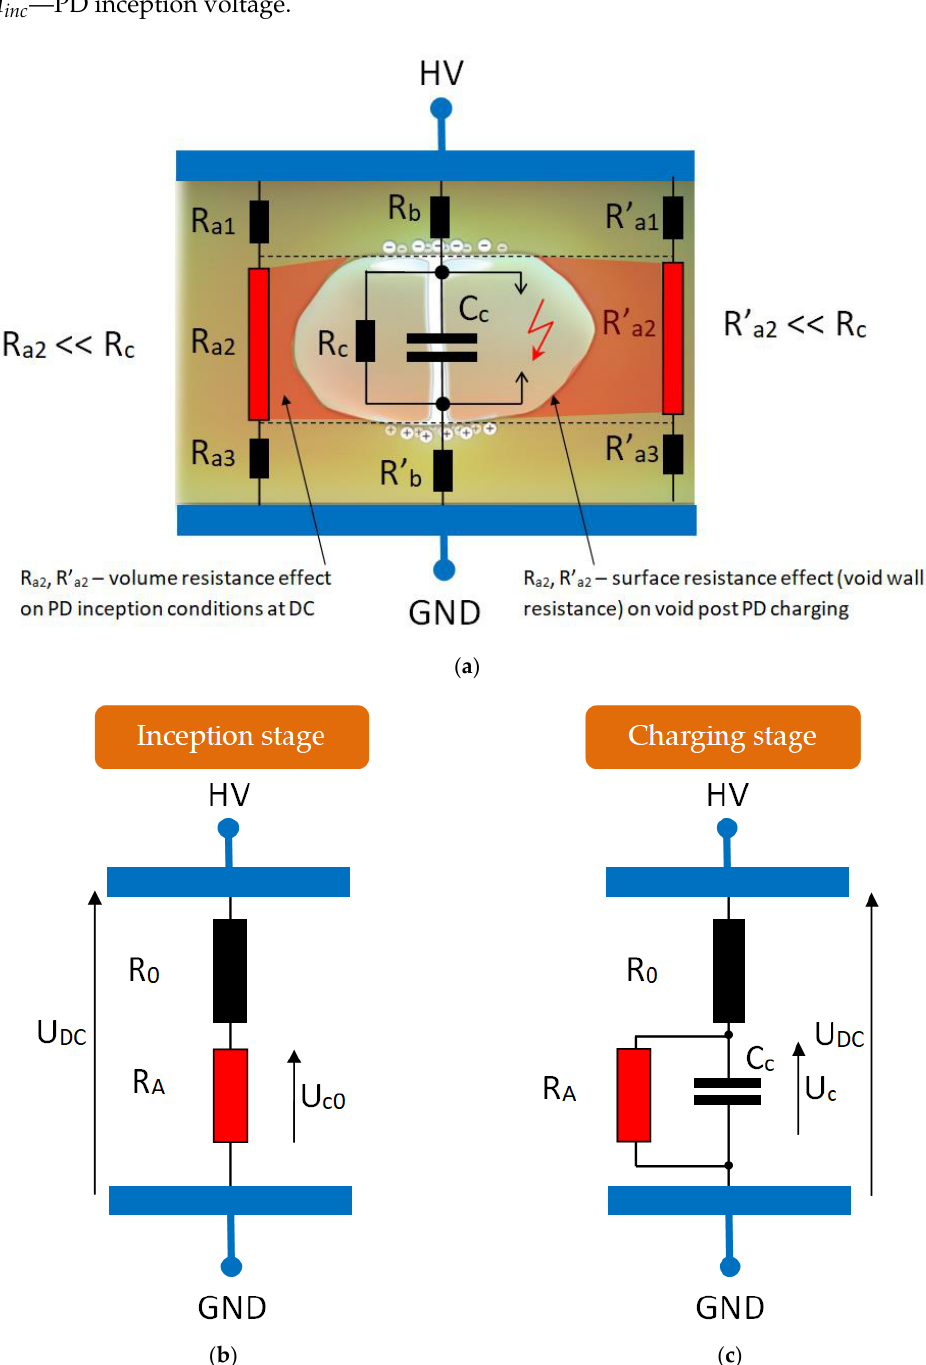
Figure 2. ( a ) PD model at DC reflecting the role of material resistivity adjacent to the void, ( b ) equivalent circuit of inception stage, R A —resistance adjacent to the void (combination of components R a 2 , R’ a 2 ), R 0 —resultant resistance from combination of components R a 1 , R’ a 1 , R a 3 , R’ a 3 , R b , R’ b , ( c ) equivalent circuit of charging stage, U DC —terminal voltage on a specimen. In a simplified form, assuming U ext = 0, t p can be expressed as: